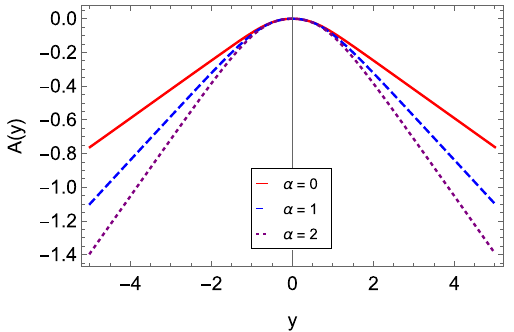
Fig. 7 Warpfunction A ( y ) resultingfromthesystemofEqs.(50)–(52) with ψ 0 = − 1, φ 0 = U 0 = k = 1 for different values of